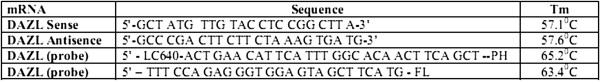
mRNA sequences for DAZL genes. Sense and antisense mRNA sequences for DAZL genes; (Tm: Melting temperature).